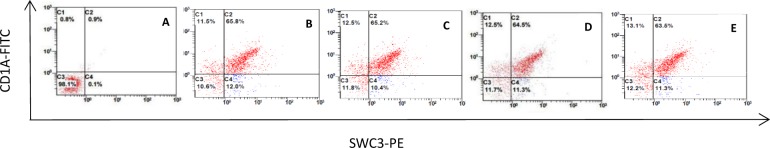
The CD1a/SWC3a dot plots of monocyte-derived DCs by flow cytometry analysis.Note: Representative flow cytometry plots showing CD1a and SWC3a staining in (A) monocyte-derived dendritic cells (DCs) alone, (B) DCs matured in co-culture with PIEC cells (PIEC-DC), and (C) DCs matured in co-culture with PCV2-infected PIECs (PCV2-PIEC-DC) are shown.